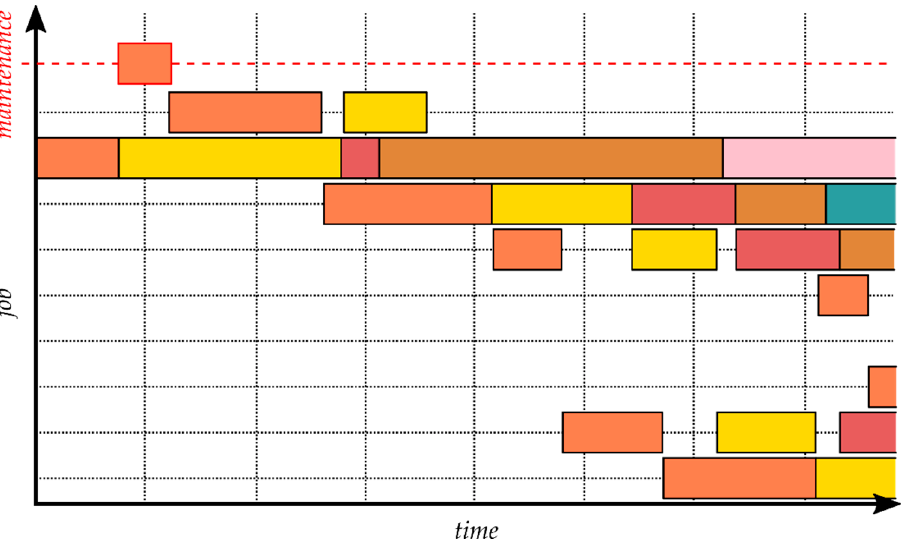
Figure 7. Optimized maintenance schedule for the use-case. The red square indicates the maintenance process.